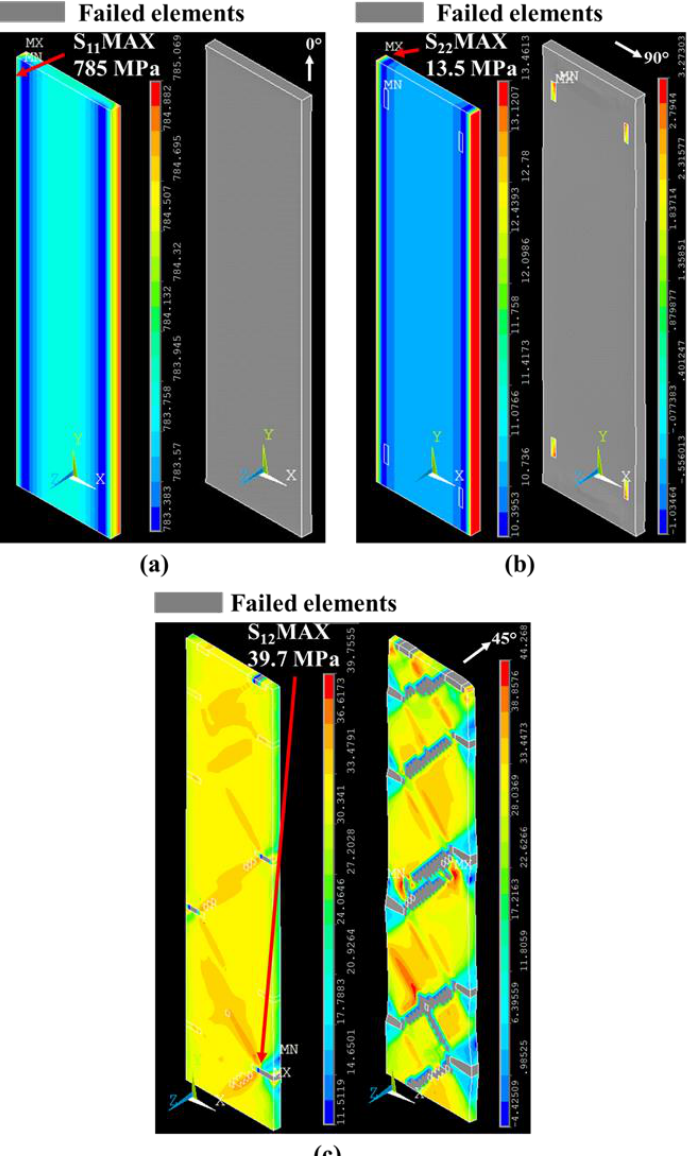
Figure 9. Failure modes of the finite element model simulations of single-angled 3D-printed GFRP specimens with ( a ) 0°, ( b ) 90°, and ( c ) 45° fiber orientations.